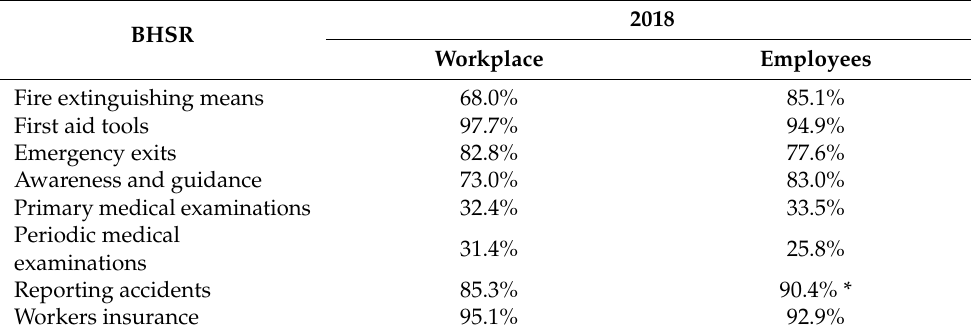
Table 3. The estimated percentages of the availability of the Basic Health and Safety Requirements (BHSR) in the industrial establishments according to the 2018 workplace questionnaire analysis.